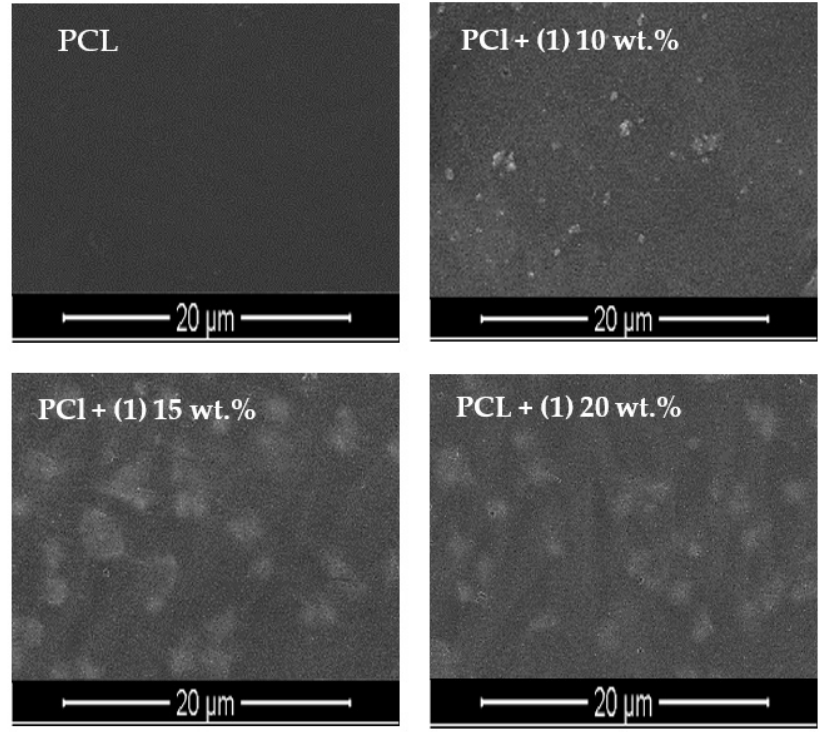
Figure 4. SEM images of PCl and PCL + ( 1 ) n wt.% composites ( n = 10, 15, and 20 wt.%).